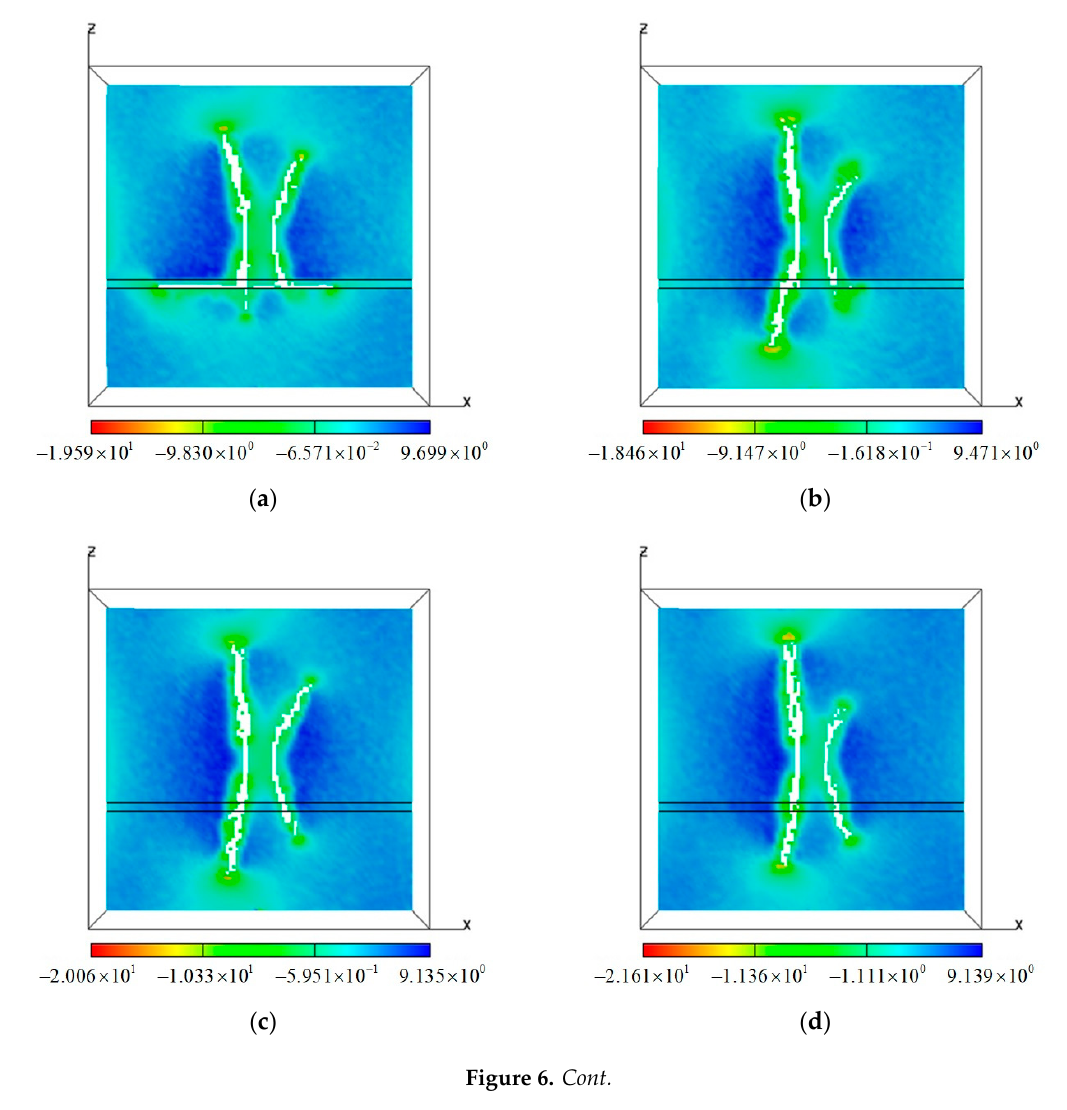
Figure 5. The hydraulic aperture (m) of the control model Multi-00: ( a ) The 3D view; ( b ) the slice at y = 0.2 m.